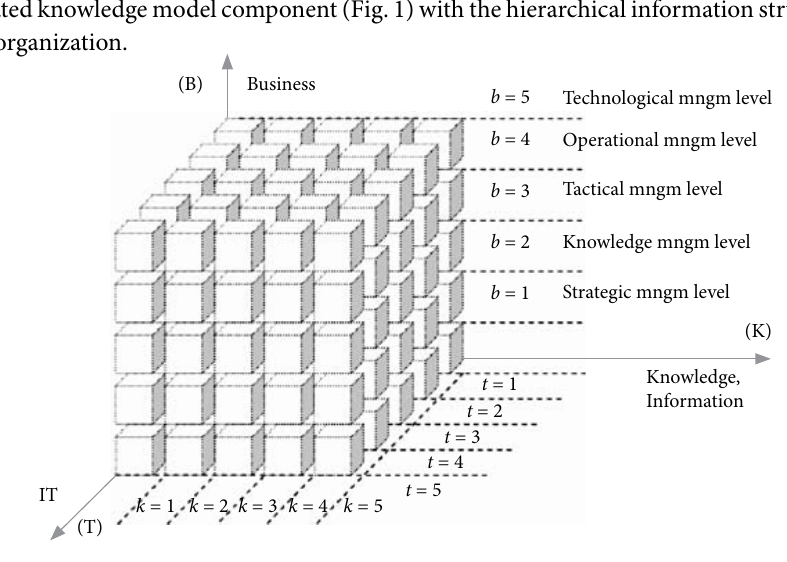
Fig. 2. Enterprise knowledge space E ( B , T , K ) (Gudas, Brundzaitė 2007)